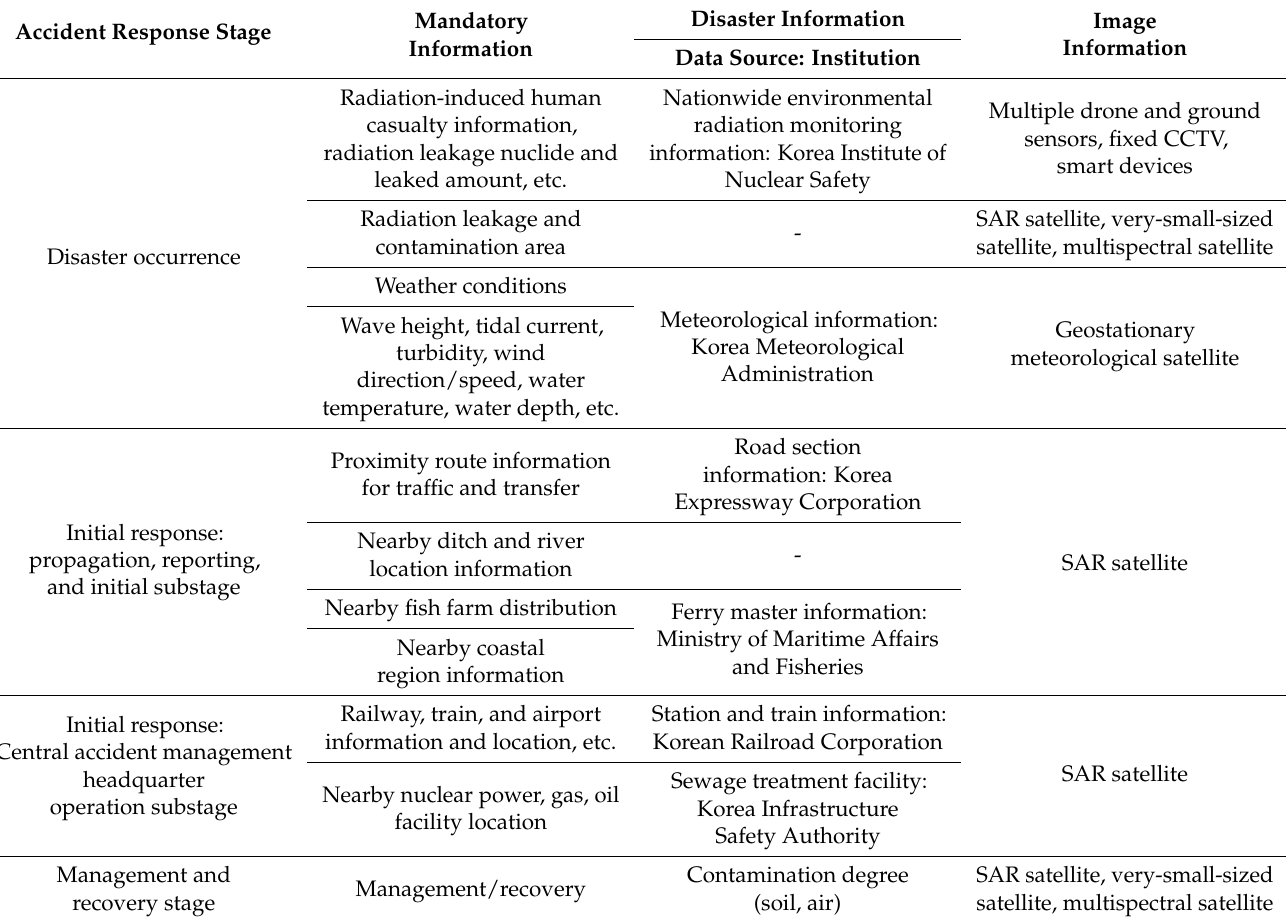
Table 9. Measure of combination of image-based spatial data (e.g., nuclear power plant